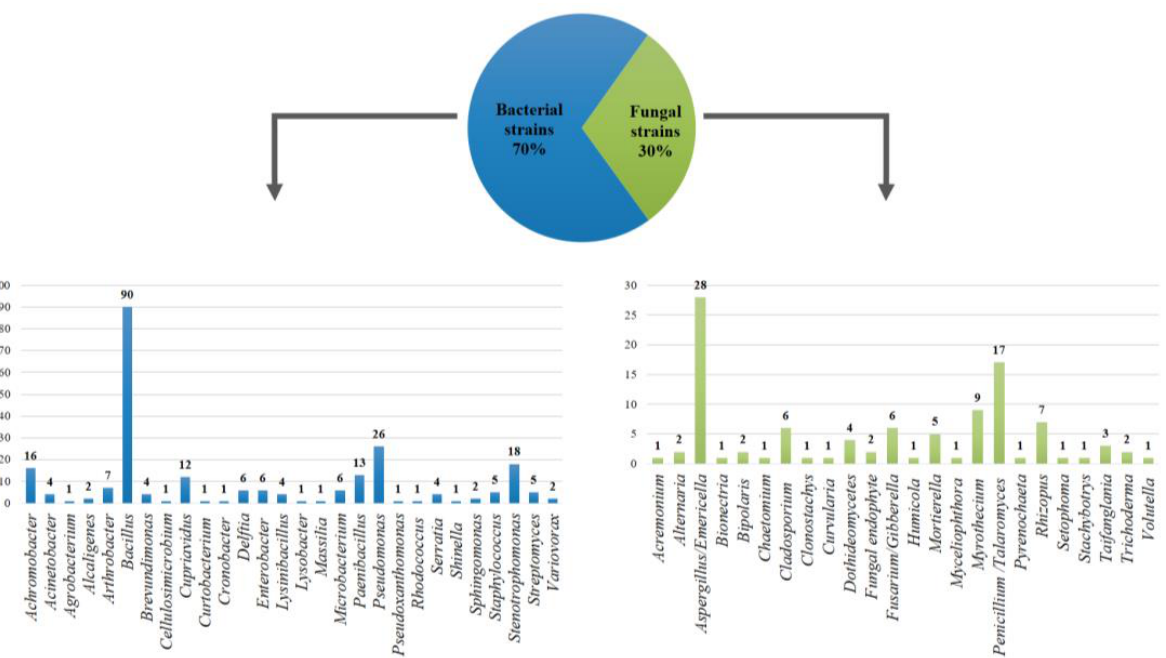
Figure 3. Bacterial and fungal diversity preserved in COLMENA obtained from the analysis of 16S rRNA and 5.8S rRNA genes, respectively.